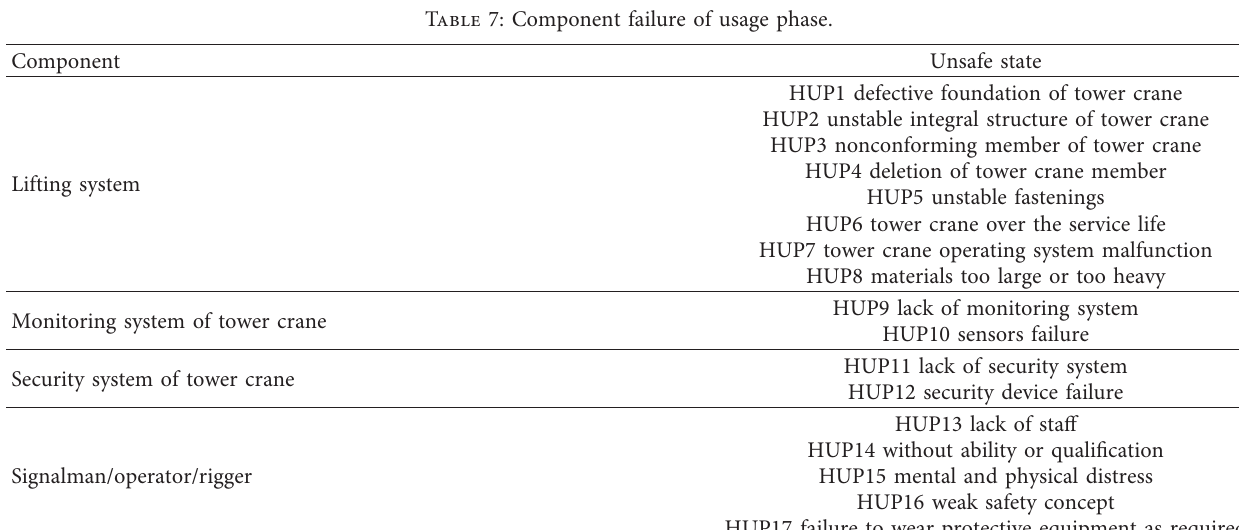
Table 7: Component failure of usage phase.